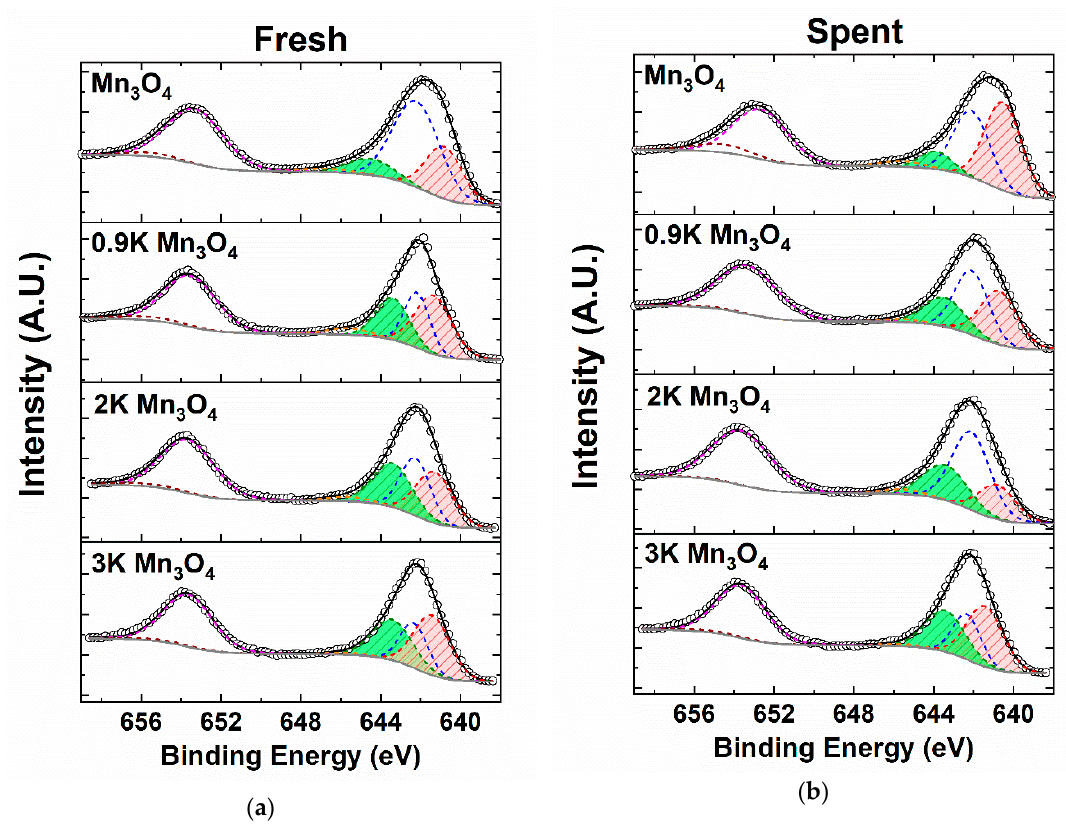
Figure 13. Mn 2p XPS spectra of: ( a ) fresh and ( b ) spent Mn 3 O 4 catalysts with varying K loadings. Colored dashed lines are the peaks utilized identified during fitting, the solid gray line is the background, and the solid black line is the fit. The low and high binding energy peaks comprising the Mn 2p 3/2 peak are shaded red and green to emphasize changes with K loading and the effect of reaction environment.